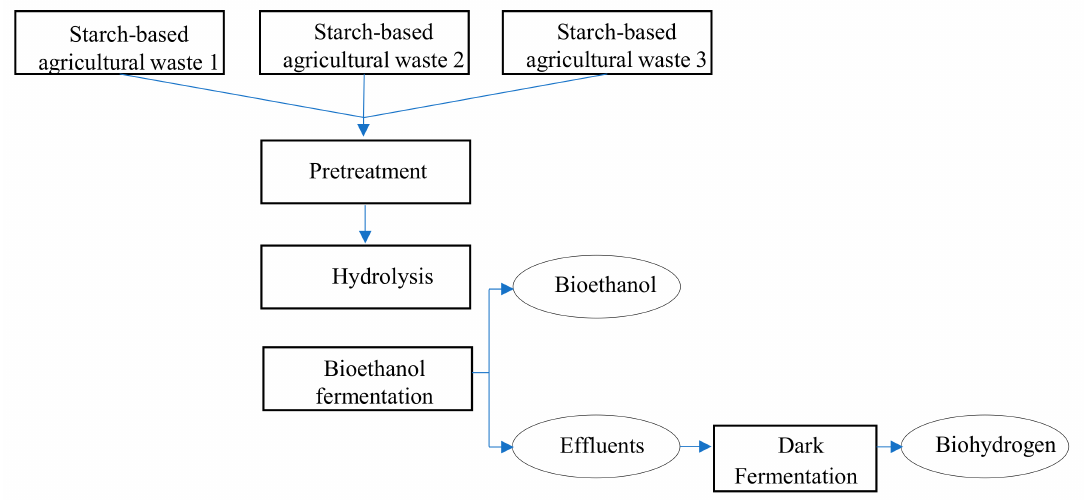
Figure 4. A proposed scheme of integrated bioethanol and biohydrogen